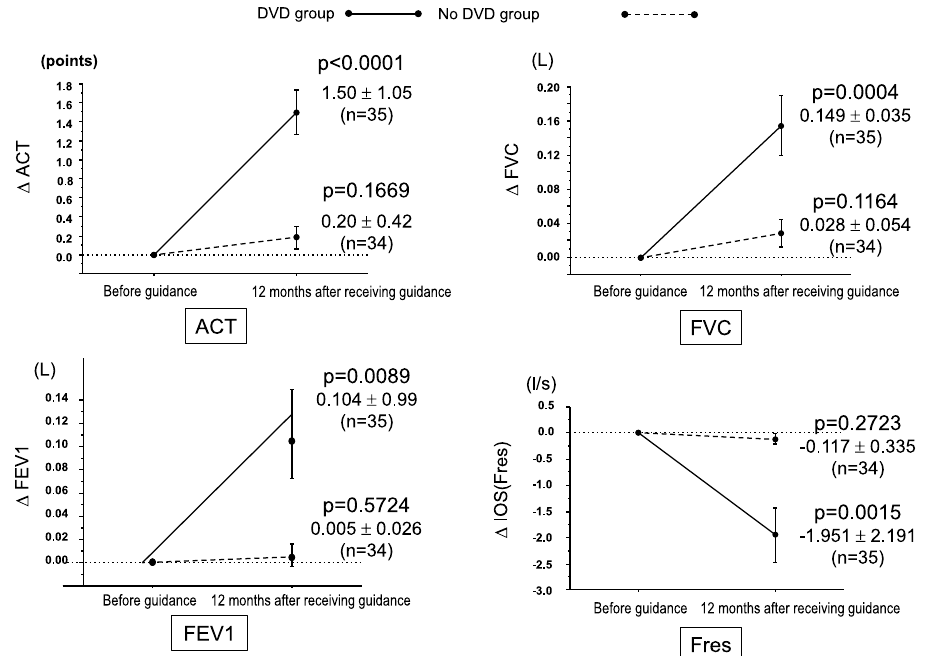
Figure 2 Changes in respiratory function parameters 12 months after undergoing inhalation guidance using a DVD.